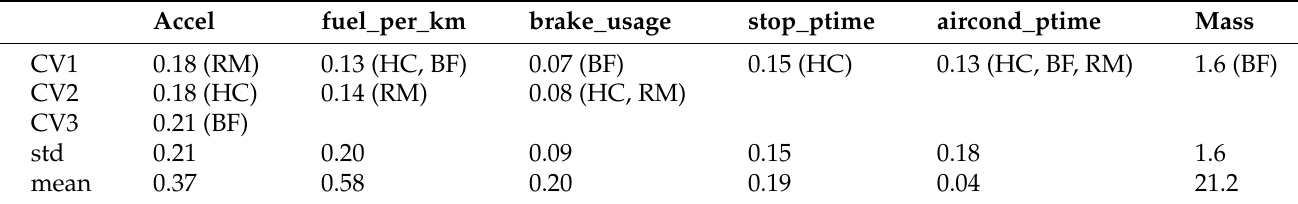
Table 3. Ten-fold cross validation (CV)-averaged rmse score for each regression of target (column) on possible parent sets identified by a Bayes network collection: { brute force (BF), hill climbing (HC), or restrictive maximization (RM) } . The first three rows list the possible parent set and ordered CV scores together with the Bayes networks that generate the given parent set. Detailed information on the parent set can be retrieved from Figure 3. The last two rows display the target mean and standard